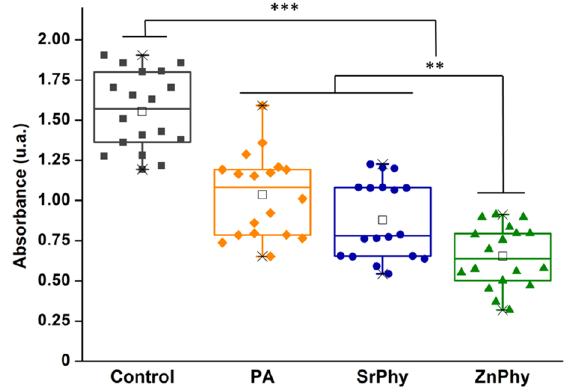
Figure 5. Relative inhibition capacity of biofilm production exhibited by CV staining of S. mutans biofilms under treatment with phytate compounds (50 µg/mL). Statistical differences between samples were analysed by ANOVA test at significant levels ** p < 0.005 and *** p < 0.001 (Tukey